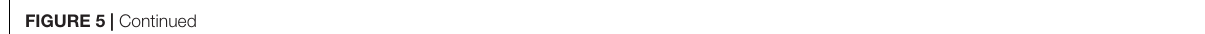
FIGURE 5 | Continued identified by RNAscope in situ hybridization. n = 28 cells from four individual animals were quantified. (F) Schematic of plasmid design for expression of a CD59 reporter construct in mature oligodendrocytes. The eyfp open reading frame was inserted after the sequence encoding the CD59 signal peptide (SP, labeled with an asterisk). (G) Example image of an individual mature oligodendrocyte at 4 dpf co-expressing membrane targeted mScarlet-CAAX and EYFP-CD59. Scale bar, 20 µ m. (H) Examples of individual myelin sheaths in micrographs as in (G) . Arrows point at discrete CD59 puncta, and arrowheads point to broader patches of CD59 localization. Scale bar, 10 µ m. (I) Phylogeny of CD59 in an unrooted phylogenetic tree. All phylogenetic relationships are in agreement with the hypothesis